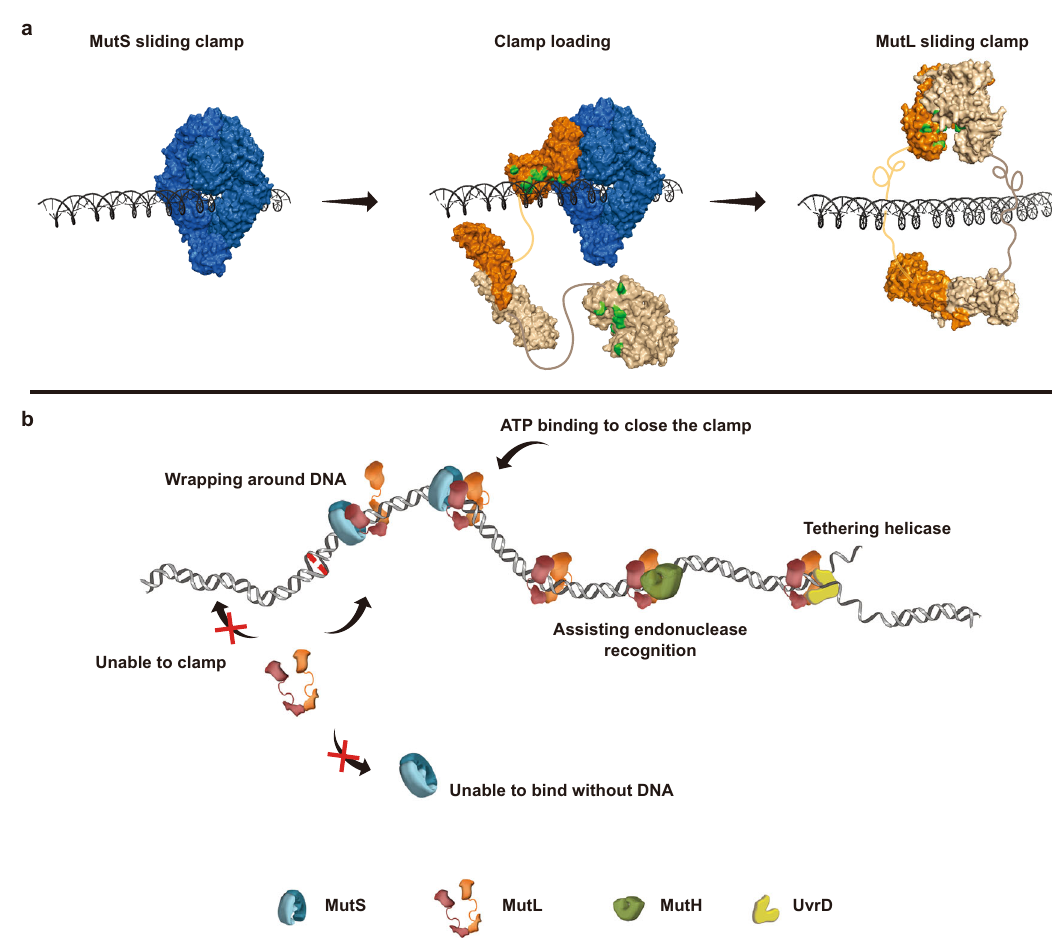
Fig. 8 | Models for MutL clamp loading by MutS with DNA and functions in MMR.a Space- fi llingmodelsofaMutSslidingclamp(left),MutLclamploadingbya MutS(center,PDBID:7AIB),and aMutLslidingclamp(right)onDNA.Thelocation of the conserved Arg/Lys residues on MutL PCC are shown in green. Intrinsic